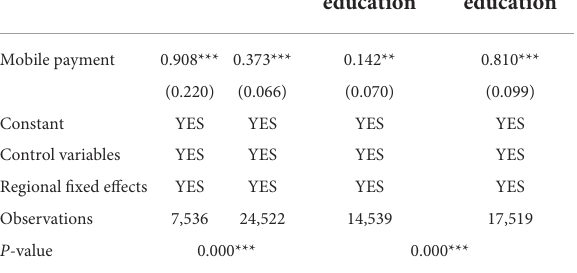
TABLE 7 Heterogeneity